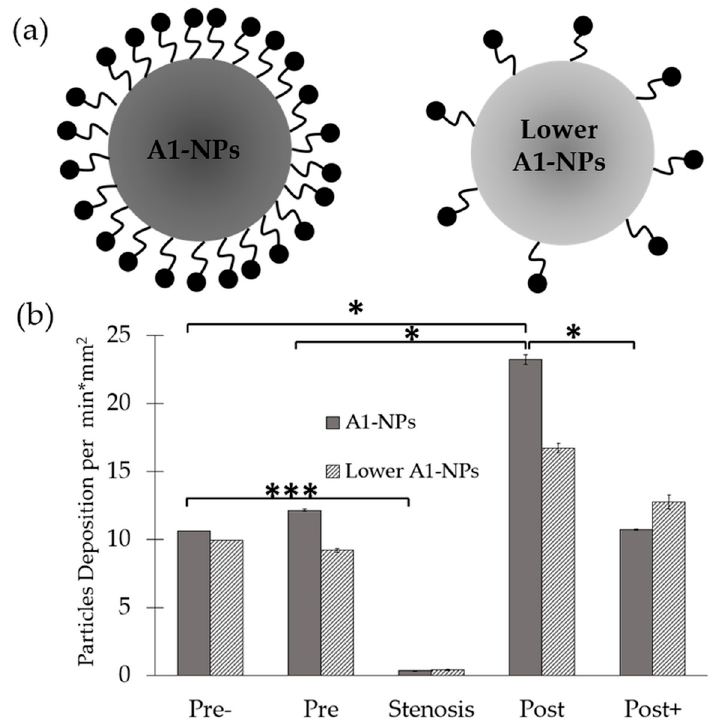
Figure 4. Spatial distribution of A1-functionalized nanoparticles in a 75% stenosis model—effect of A1-NPs coating density on the nanoparticles. ( a ) Schematic representation of A1-NPs and lower avidity A1-NPs. A1-NPs were functionalized with ~5000 copies per µm 2 while the lower avidity A1-NPs with ~50 copies per µm 2 . ( b ) A graph showing the normalized deposition at different zones along the stenotic model for A1-NPs vs. the lower avidity A1-NPs.